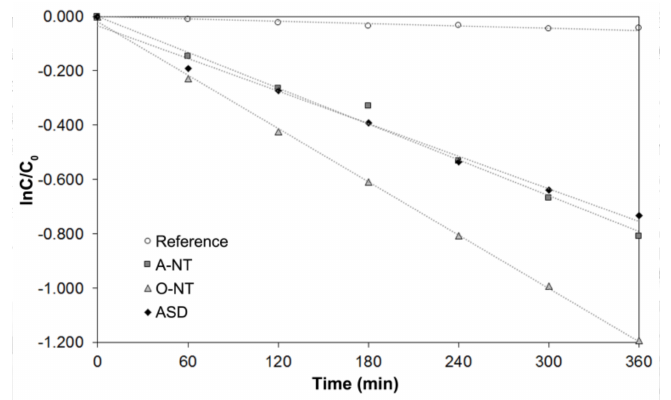
Figure 3. Kinetic plot for RhB